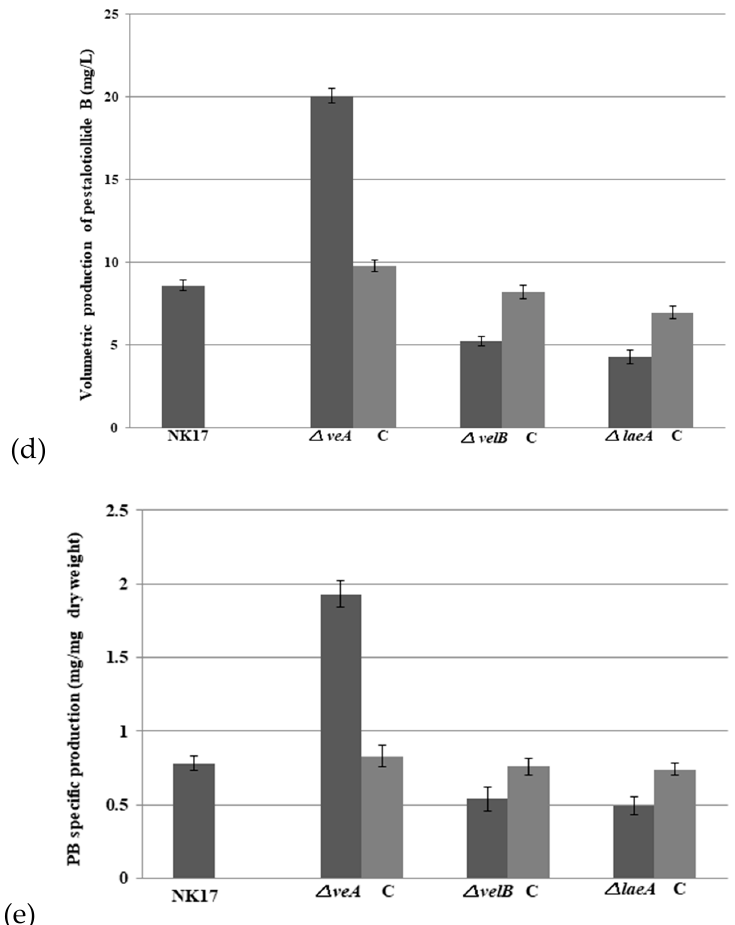
Figure 4. Effects of veA , velB , and laeA on secondary metabolism. High performance liquid chromatography (HPLC) profiling was conducted for secondary metabolites extracted from the liquid cultures of NK17 (black line), the three mutants (blue line), and the respective complement strains (pink line). Fungal strains were grown in 200 mL potato dextrose both, shaken at 28 °C, 180 rpm for seven days. The peak of pestalotiollide B (PB) is indicated by the red arrow. ( a ) HPLC profiling for △ veA as shown in green. ( b ) HPLC profiling for △ velB (green). ( c ) HPLC profiling for △ laeA (in green). ( d ) Volumetric production of pestalotiollide B in NK17, △ veA , △ velB , and △ laeA strains. ( e ) Qualification for the yield of PB in NK17, △ veA , △ velB , and △ laeA strains by the dry weight of mycelium. HPLC profiling for each strain was performed in triplicate. Error bars indicate standard errors.